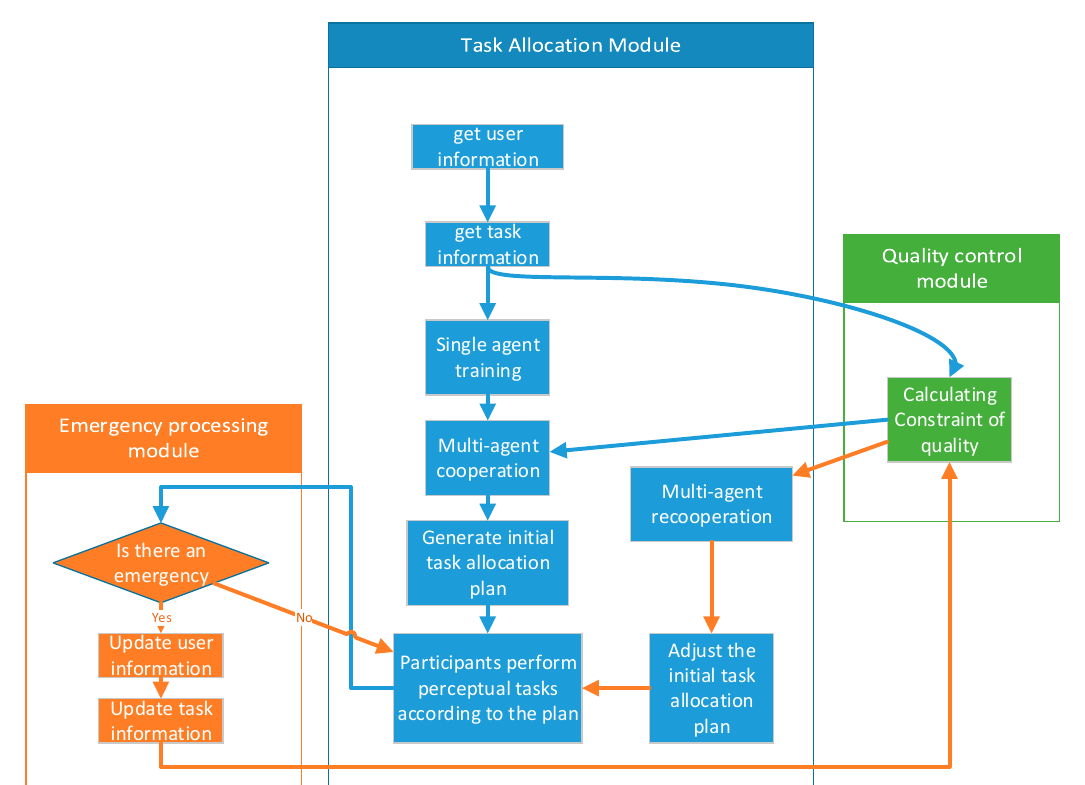
Figure 3. Task allocation system framework.